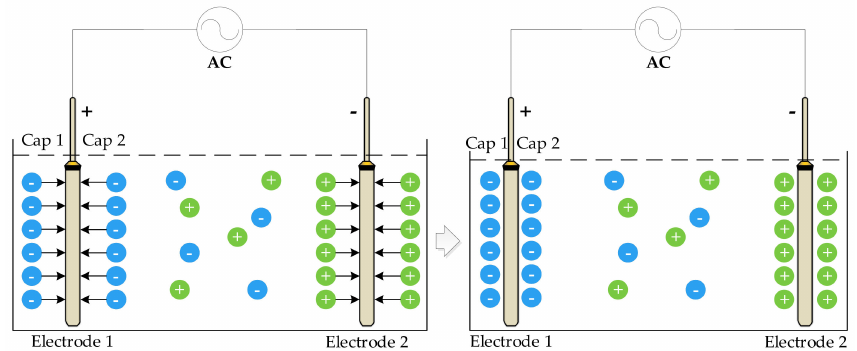
Figure 2. Schematic diagram of the capacitance